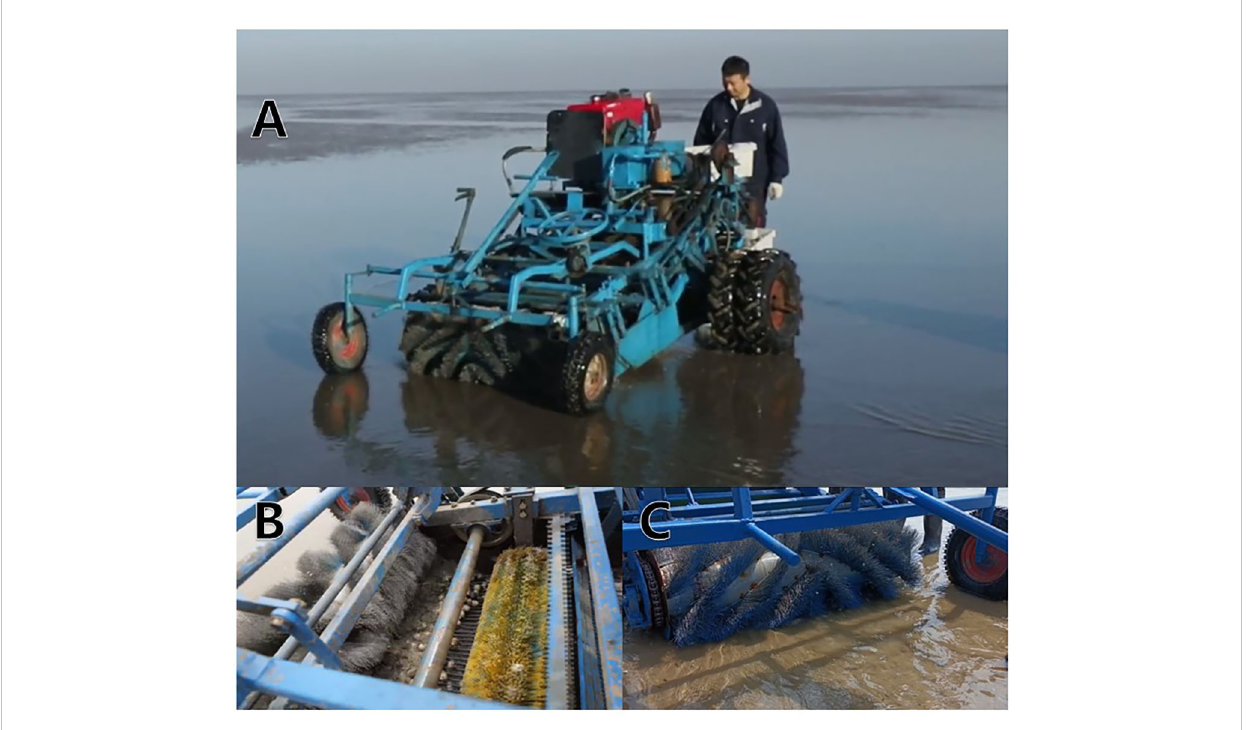
FIGURE 10 Shell fi sh vibration harvesting test: (A) The equipment harvesting operation, (B) The shell fi sh vibrating screening, (C) First-stage brush sediments cutting